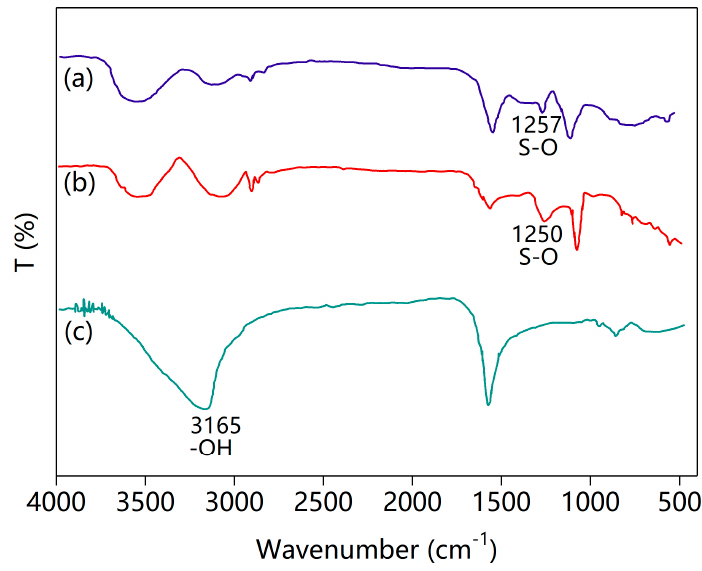
Figure 6. Attenuated total reflectance Fourier transform infrared (ATR–FTIR) spectra of ( a ) mixture of PMS and BiOBr, ( b ) PMS solution and ( c ) BiOBr suspension. Initial pH of the pure water was 5.7; the PMS solution was adjusted to pH 5.7.